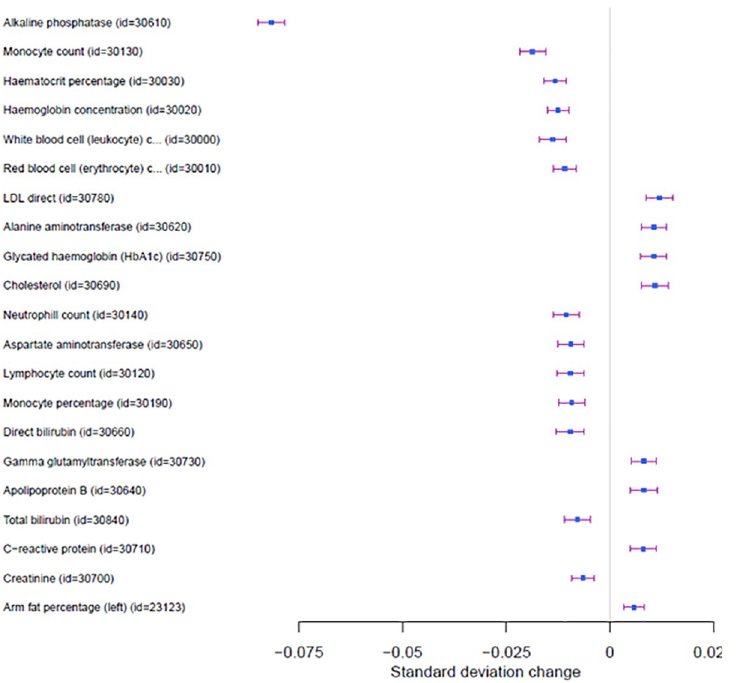
Fig 3. Forest plot of Phewas analyses of general COVID-19 susceptibility.